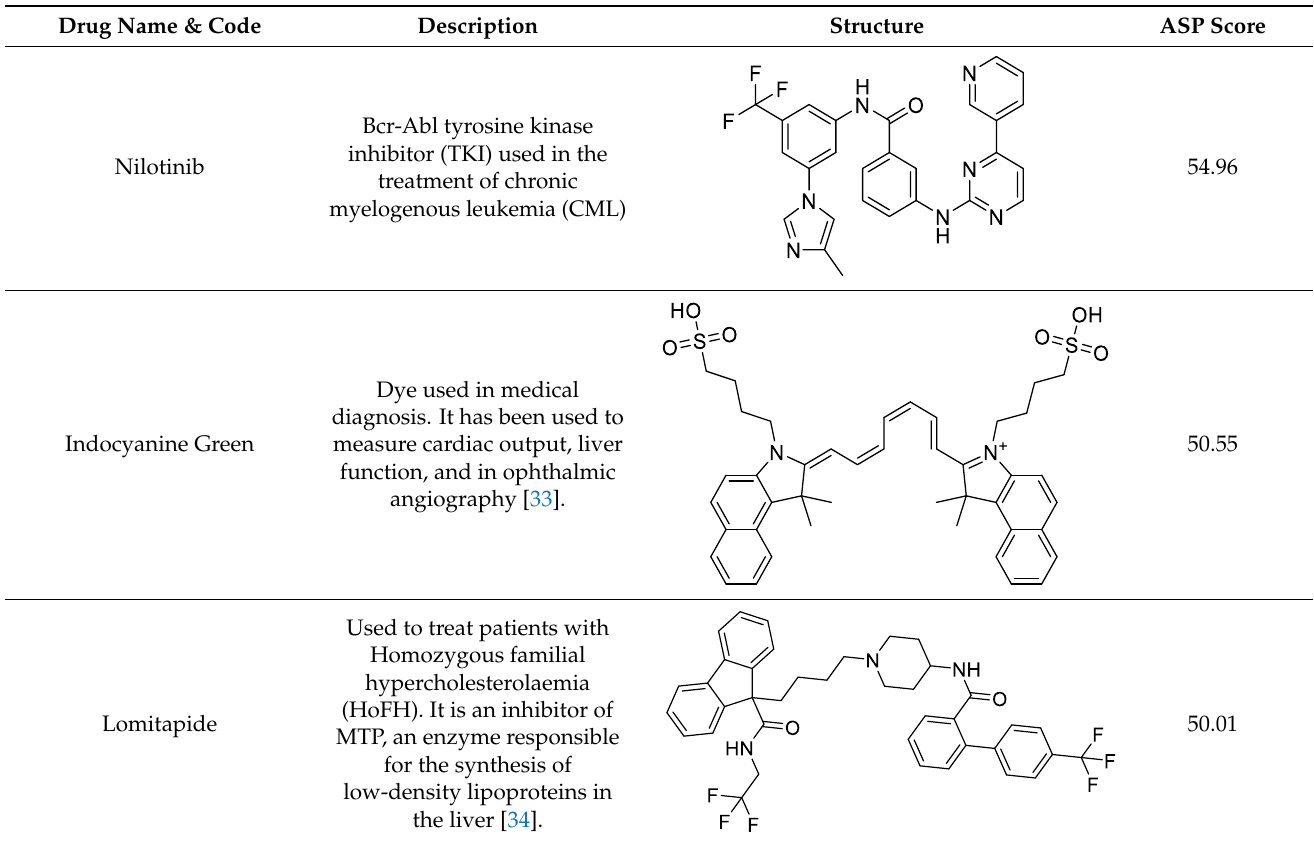
Table 3. Top 15 hits of the FDA-approved drugs database.